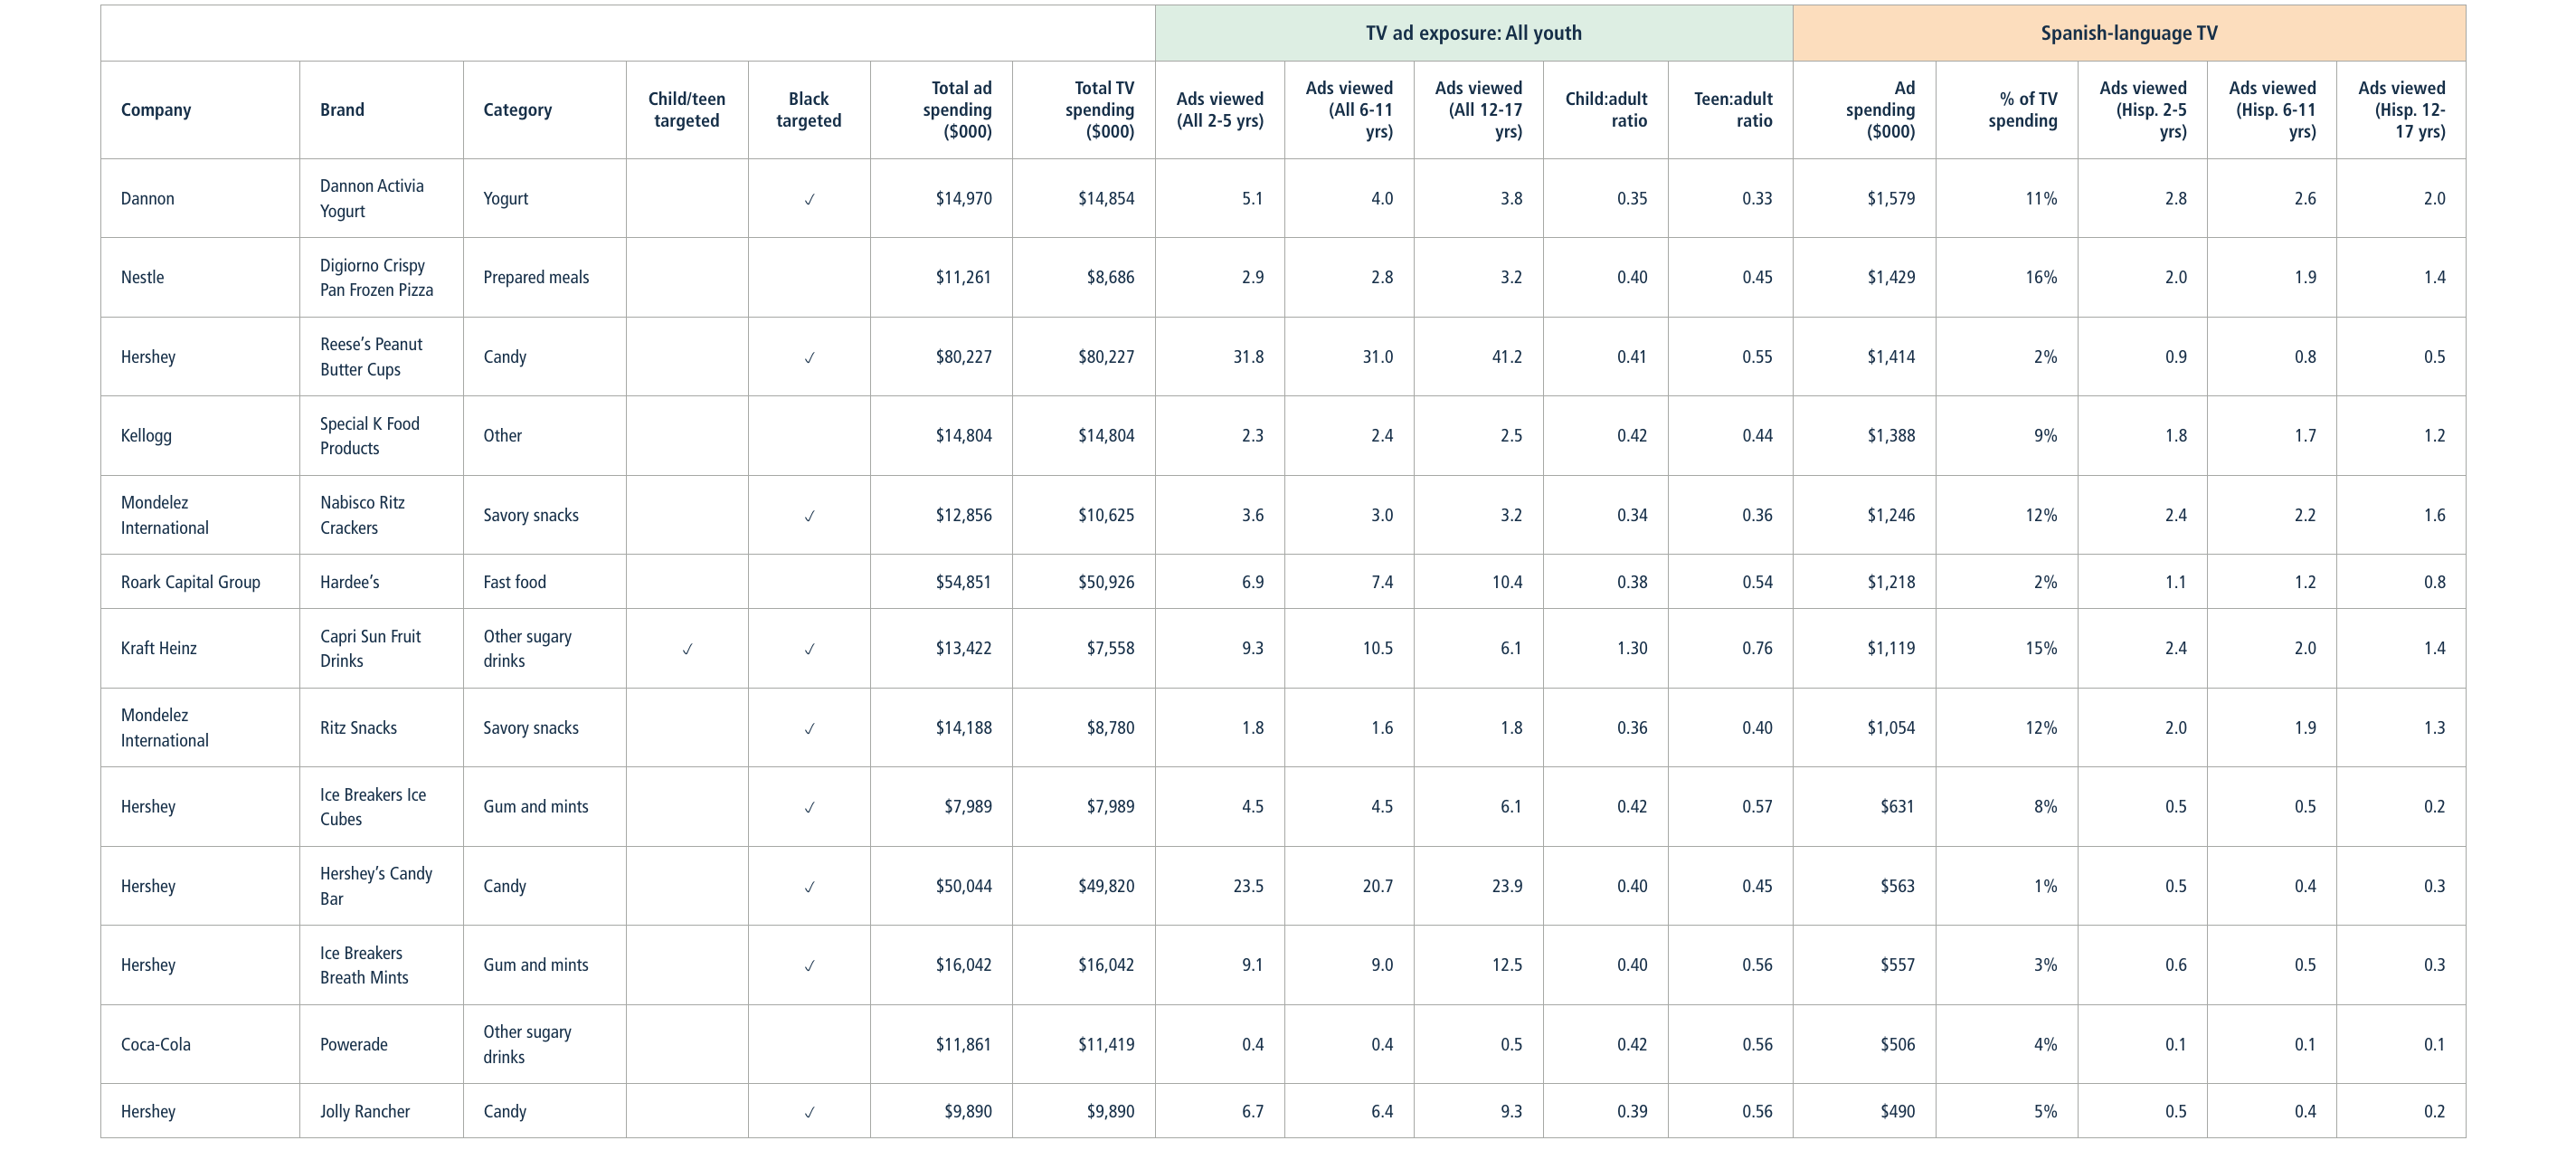
TABLE 2. BRANDS TARGETED TO HISPANIC CONSUMERS